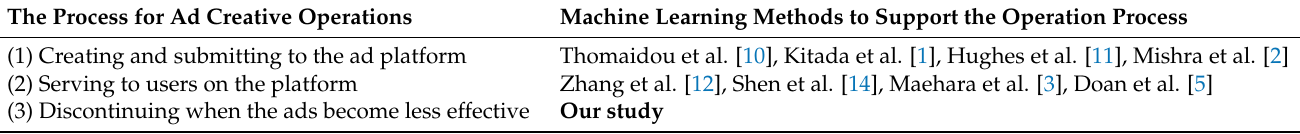
Table 1. Classification of machine learning methods to support the process for ad creatives. The Process for Ad Creative Operations Machine Learning Methods to Support the Operation